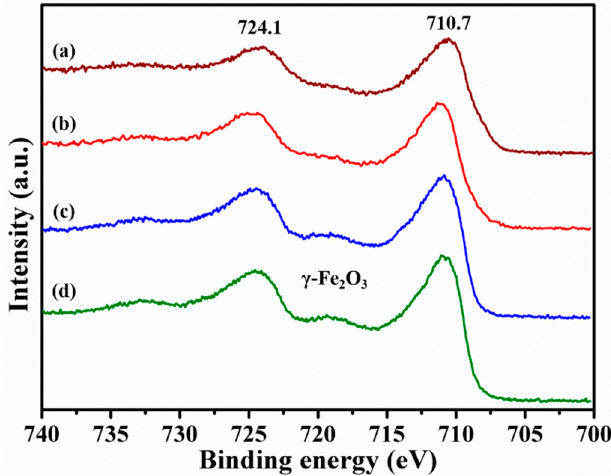
Figure 10. XPS Fe 2p core level spectra of ( a ) ground CRS, ( b ) PI, ( c ) AT, and ( d ) EIO.